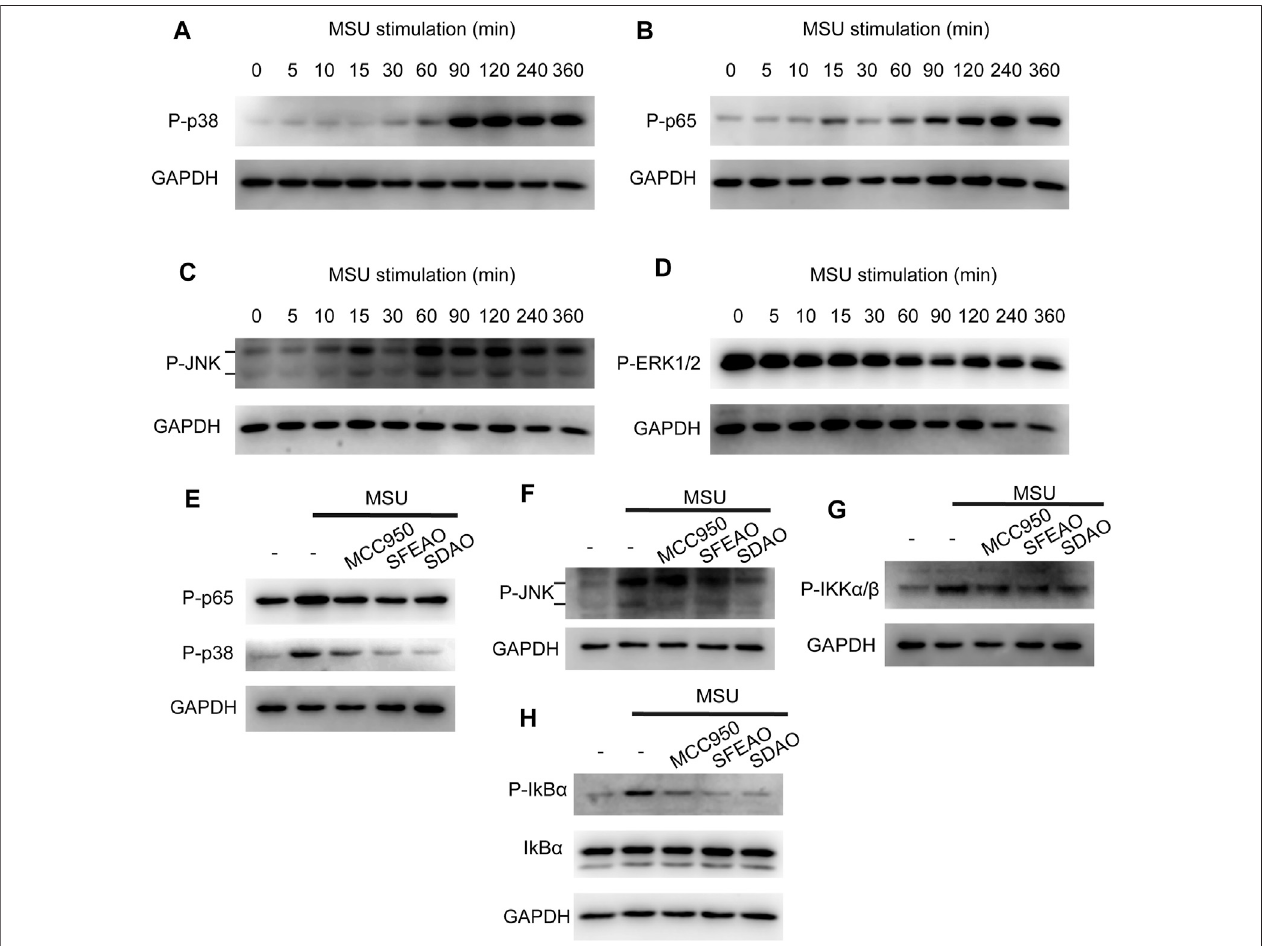
FIGURE 6 | EOAA inhibited the phosphorylation of p65, p38, IKK, IkB α and JNK at 90 min after MSU treatment. PMA-primed THP-1 cells were stimulated with MSU (500 μ g/ml) for different durations. The protein expression levels of p-p38 (A) , p-p65 (B) , p-JNK (C) and p-ERK1/2 (D) in the cytoplasm were measured utilizing immunoblotting. PMA-primed THP-1 cells were treated with or without MCC950 (20 µM), SDAO (45 µg/ml) or SFEAO (136 µg/ml) upon stimulation with MSU (500 µg/ ml) for90 min. Thephosphorylationofp65, p38 (E) ,JNK (F) , IKK α / β (G) , andIkB α (H) inwhole-cell extractswasmeasured byimmunoblotting. GAPDHwasacted as internal